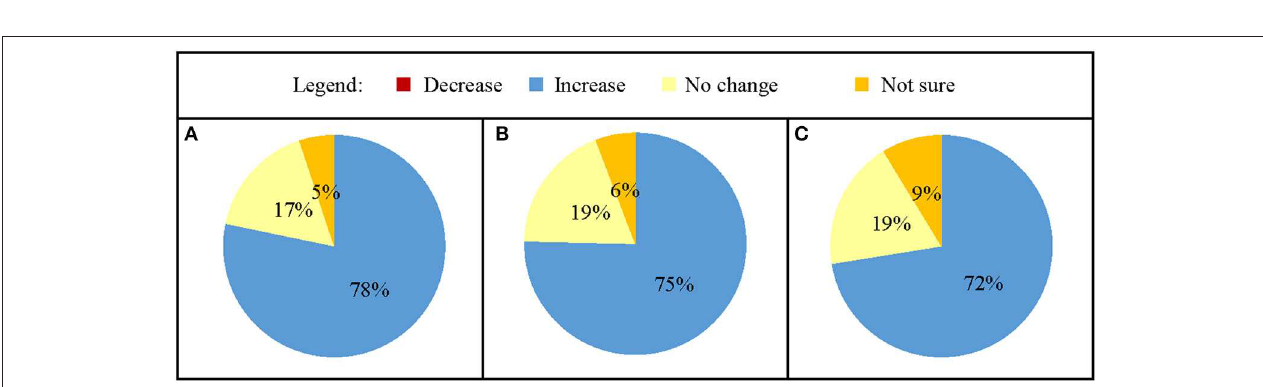
FIGURE 13 | Consumers’ market access. Total informant level of agreement with statements regarding market and access of lentils reported by informants that include (A) lentils are readily available at the market of our choice, (B) lentils are sold at an affordable and reasonable price, (C) lentils of all types are accessible in the community, (D) the lentils purchased meet expectations on the basis of taste, aroma, texture, and palatability ( n = 70).